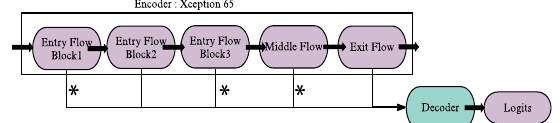
Figure 4: Deep-U-Lab . The newly added skip connections are marked by "*". Best if viewed on